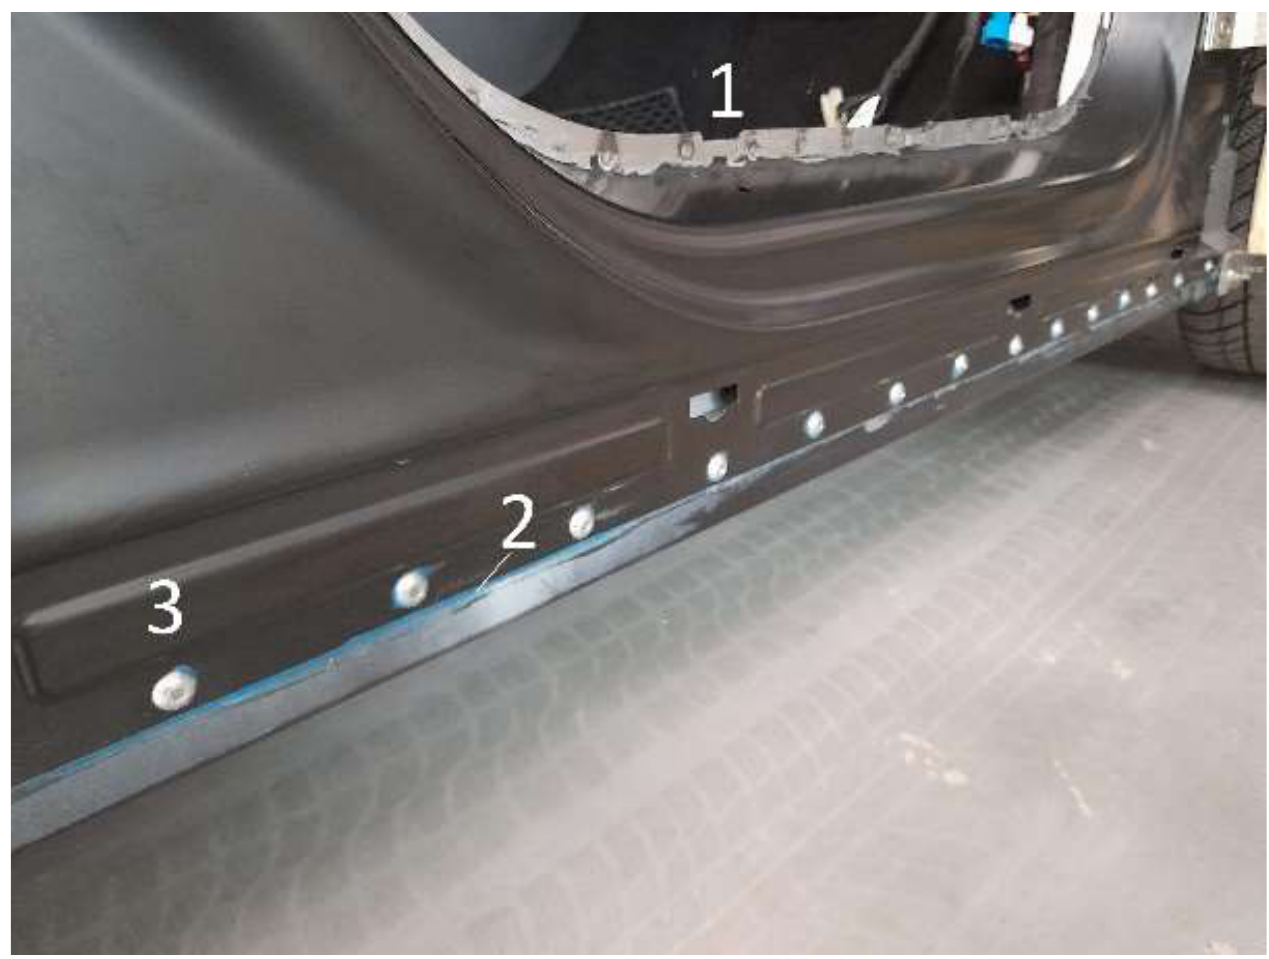
Figure 2. Joints used in car body repair; 1—weld; 2—adhesive; 3—classic rivet.